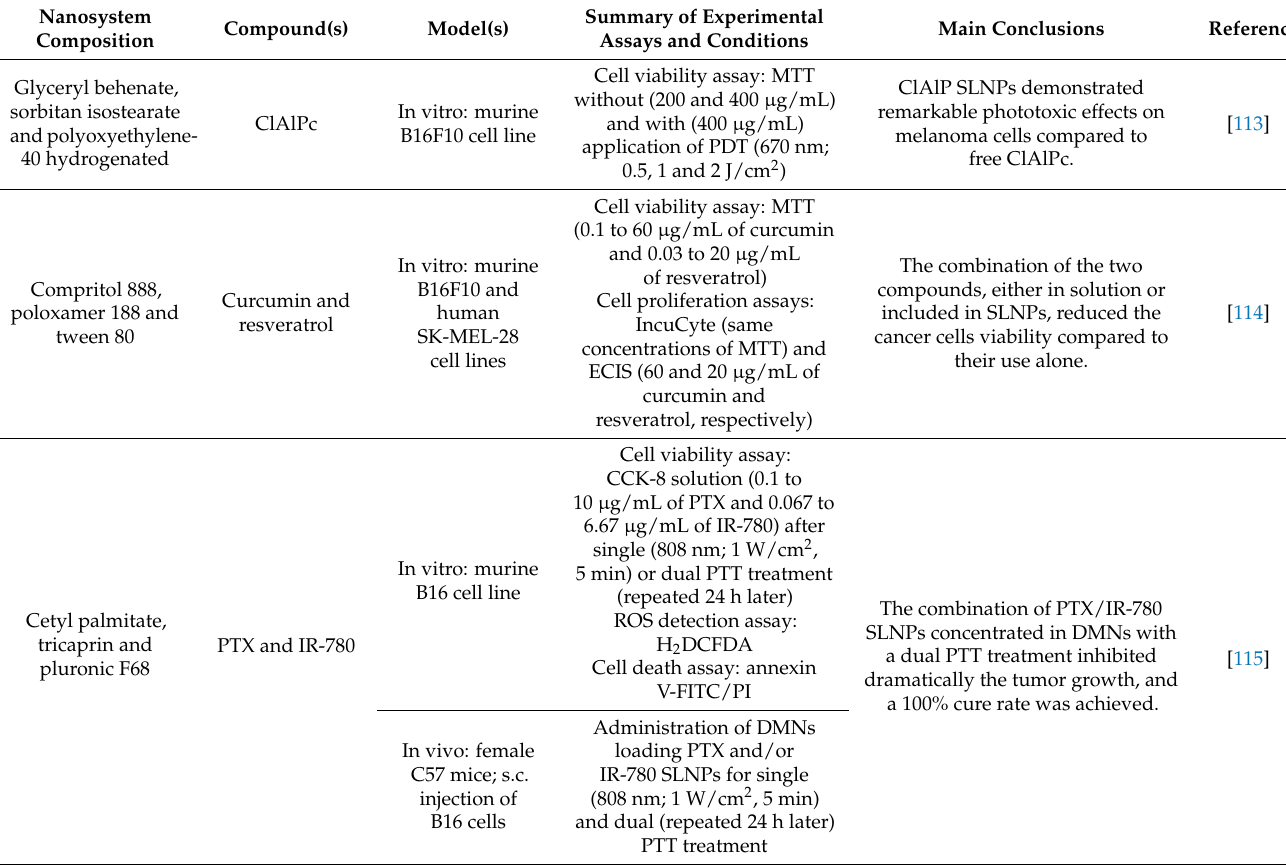
Table 2. In vitro and in vivo assessment of the therapeutic potential of different SLNPs in melanoma